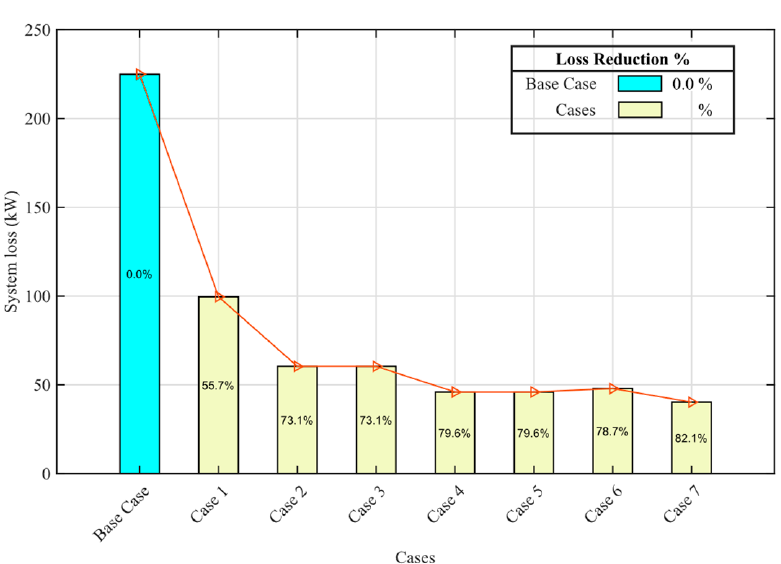
Figure 8. The optimal SR and two SOP locations for the IEEE 33-node radial DS.